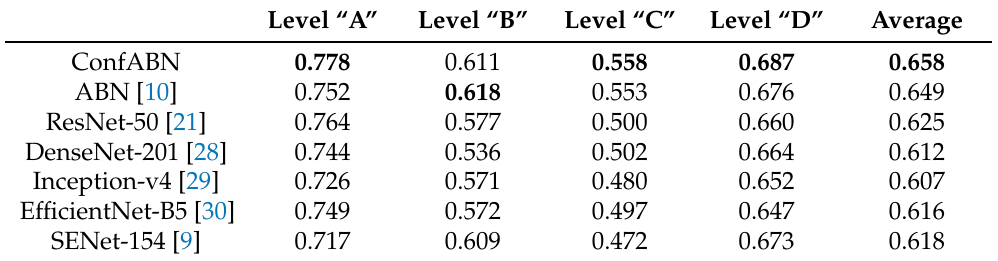
Table 6. F-measure of ConfABN and comparative methods in estimating deterioration levels of crack.